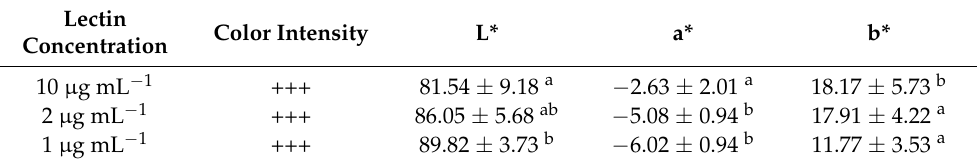
Table 1. Validation of Arachis hypogaea lectin reactivity on a sample of processed cheese.